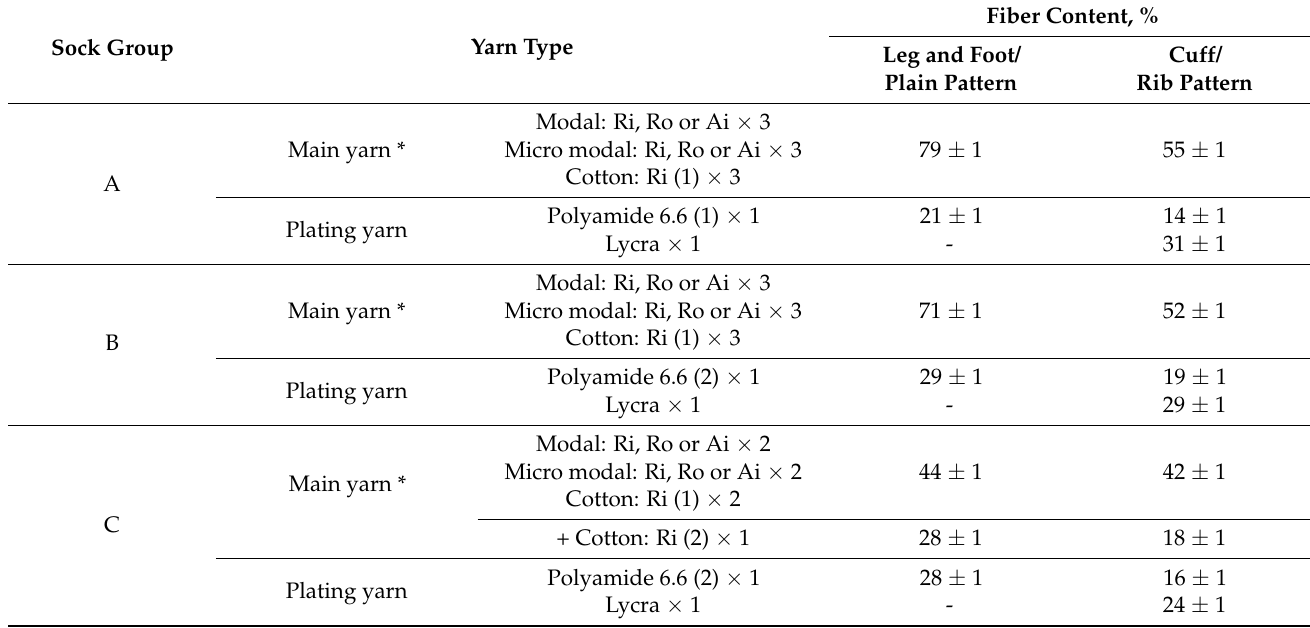
Table 3. Specification and structure characteristics of the socks